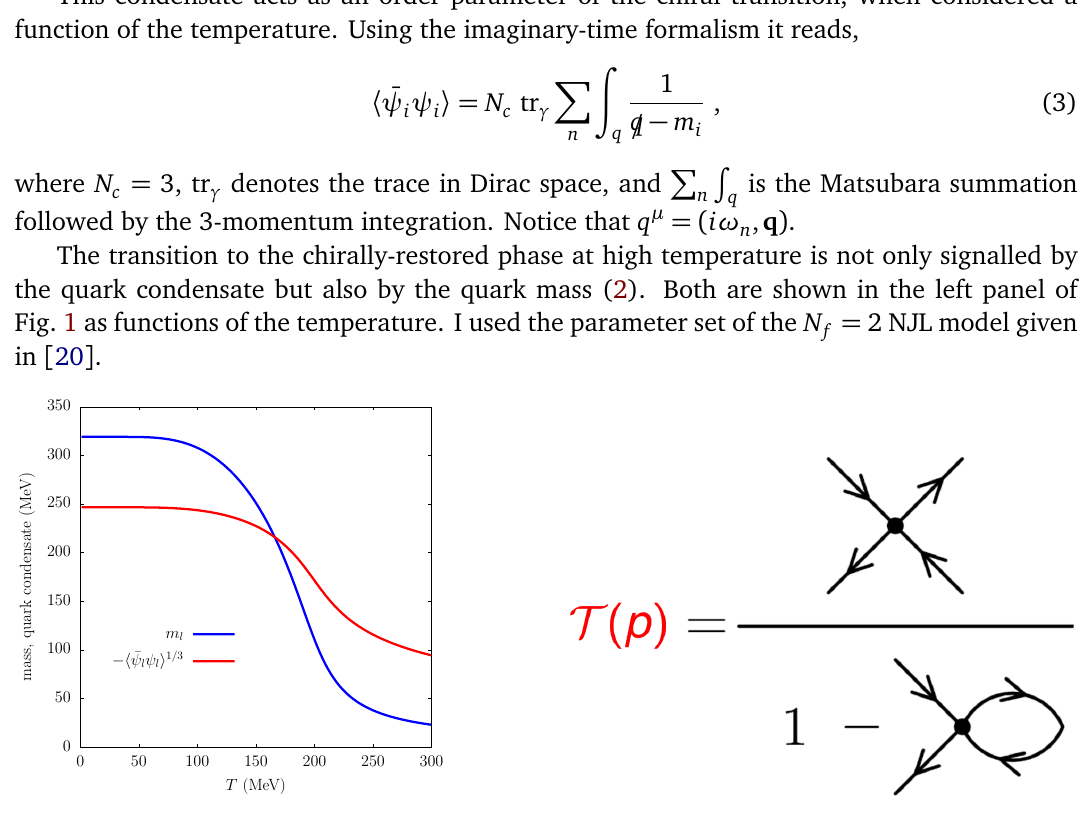
Figure 1: Left: Quark mass (blue) and quark condensate (red) as functions of the temperature of the 2-flavor NJL model within the mean-field approximation. Right: Diagrammatic solution of the T -matrix equation (6) in terms of the quark-antiquark interaction vertex of the NJL model G (represented by the black